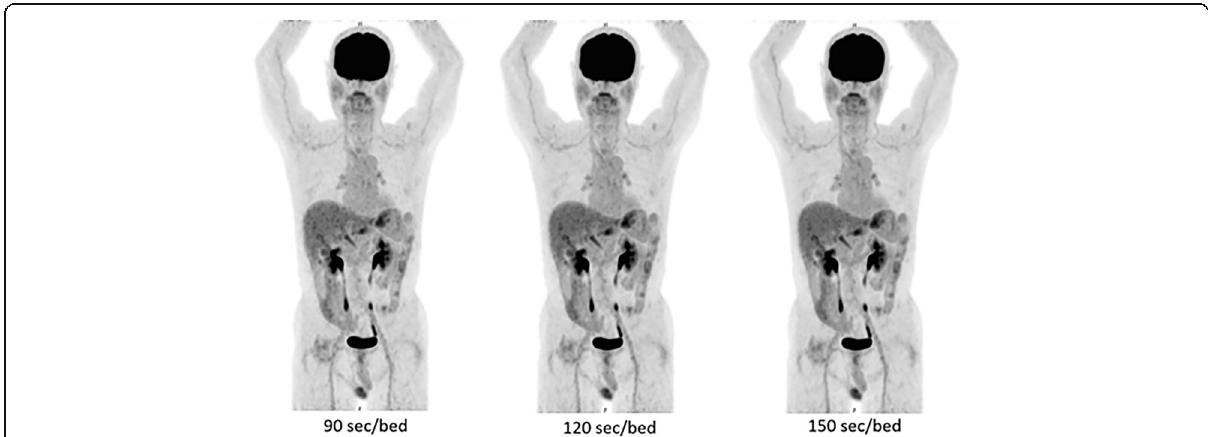
Fig. 10 Sample clinical images with different acquisition times. This patient is a 71-year-old man with a height of 159 cm and a weight of 53.2 kg. Left: 90 s/bed position, middle: 120 s/bed position, right: 150 s/bed position. The PET scan was performed 63 min after the injection of 192.8 MBq (3.62 MBq/kg)